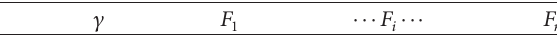
Table 2: Representation of a solution set.